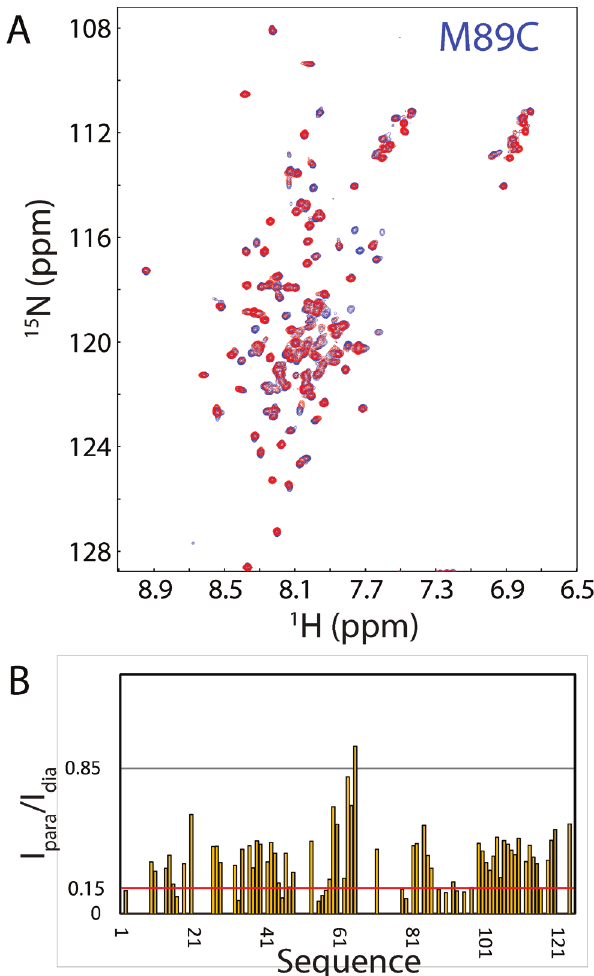
Figure 8. Representative 15 N HSQC PRE data used to derive long-range distance restraints for structure determination. A . Overlay of two NMR HSQC spectra of spin-labeled M89C in the paramagnetic state of the MTSL probe (red) and diamagnetic state after the MTSL probe has been reduced (blue). The HSQC spectra were recorded on a 200 μM 15 N-labeled M89C sample at 800 MHz and 313 K. B . Intensity ratios of HSQC peaks of spin-labeled M89C from the paramagnetic and diamagnetic